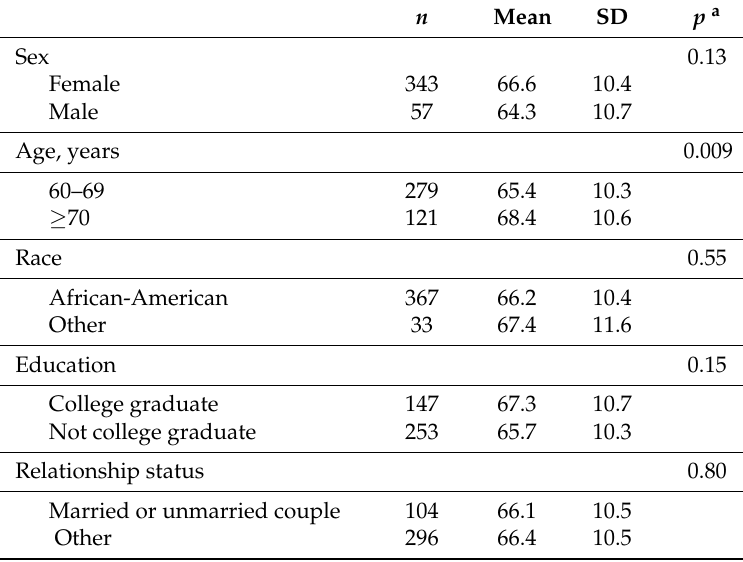
Table 4. Healthy Eating Index-2010 total score by subject